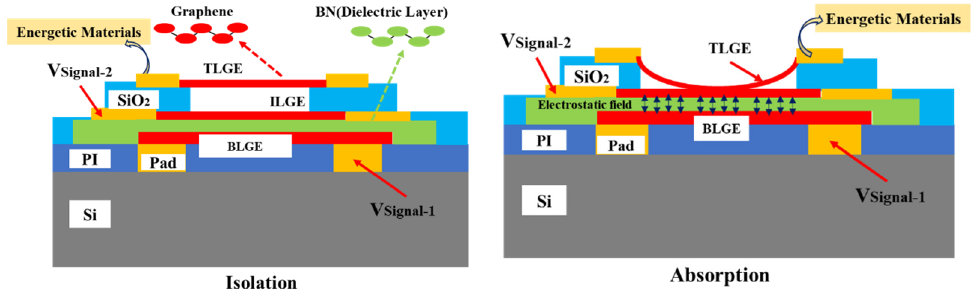
Figure 1. Functional matching model of insurance actuator and energetic materials.